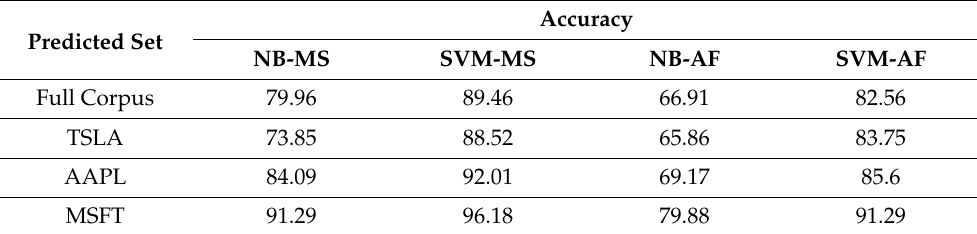
Table 6. Results of Machine Learning Sentiment Analysis Classification.